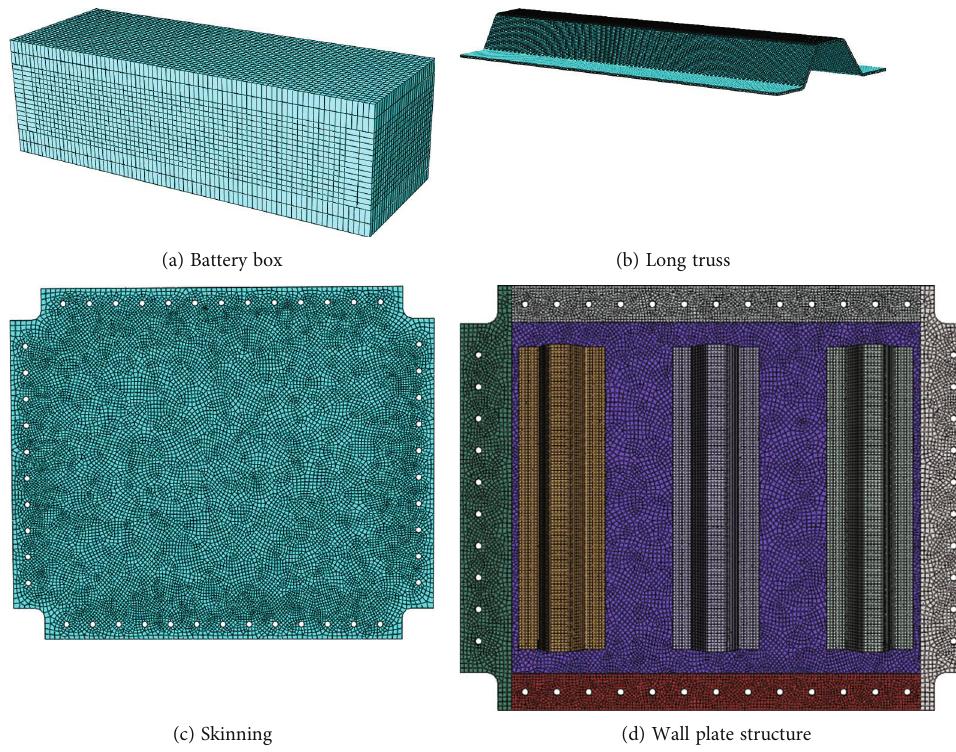
Figure 4: Grid diagram of the structure of cap-type-reinforced composite wall plate and battery box. Table 2: T300/epoxy composite properties [9, 10].